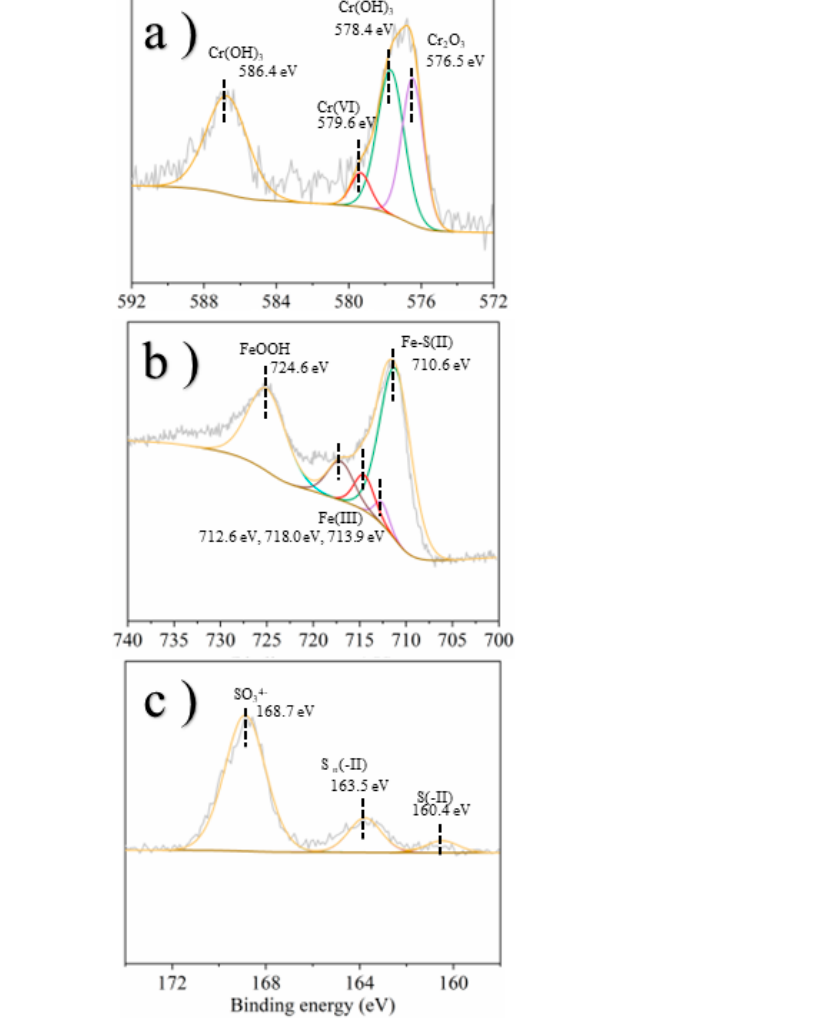
Figure 4. XPS spectra of ( a ): Cr 2p1/2, ( b ): Fe 2p3/2, and ( c ): S 2p3/2 after reaction in the presence of FeS. Solid samples were prepared under the following experimental conditions: FeS 1+x = 11.4 mM; initial Cr(VI) = 1.14 mM; stirring speed = 200 rpm. The C1s peak at 284.8 eV was chosen to calibrate all the peak positions. Table 2. XPS analysis fit results of Cr(VI) 2p1/2, S 2p3/2 and Fe 2p3/2 under anoxic conditions. BS- FeS 1+x : biosynthesis of iron sulfides containing SRB.